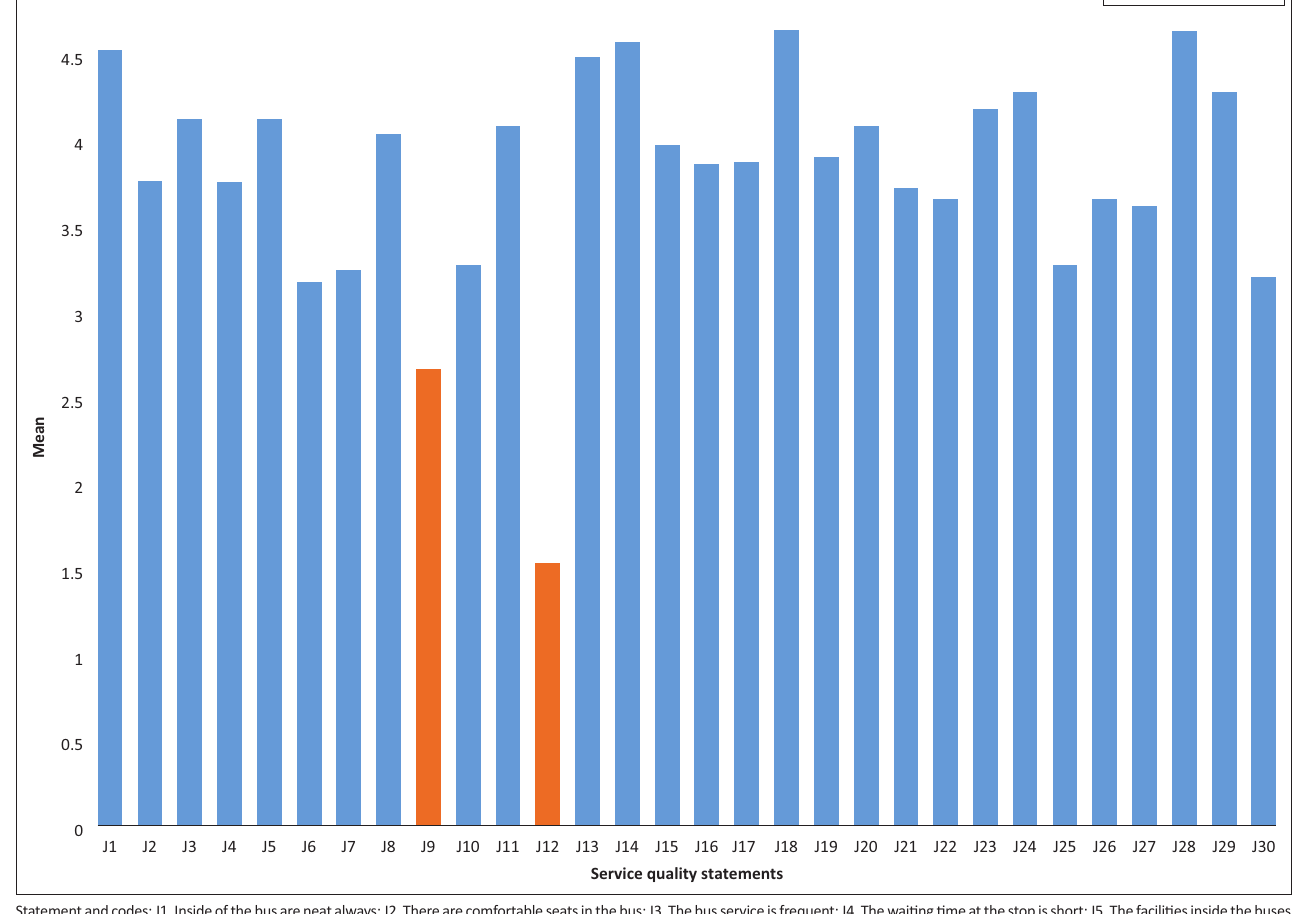
FIGURE 2: Mean distribution of MyCiti bus passenger responses to service quality